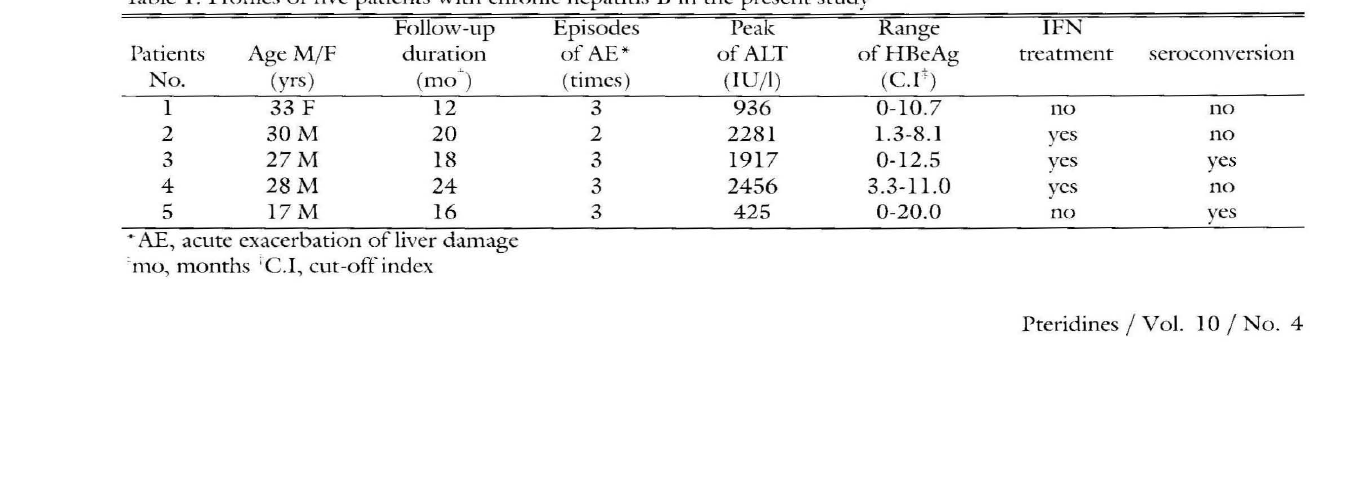
Table 1. Profiles of five patients with chronic hepatitis B in the present